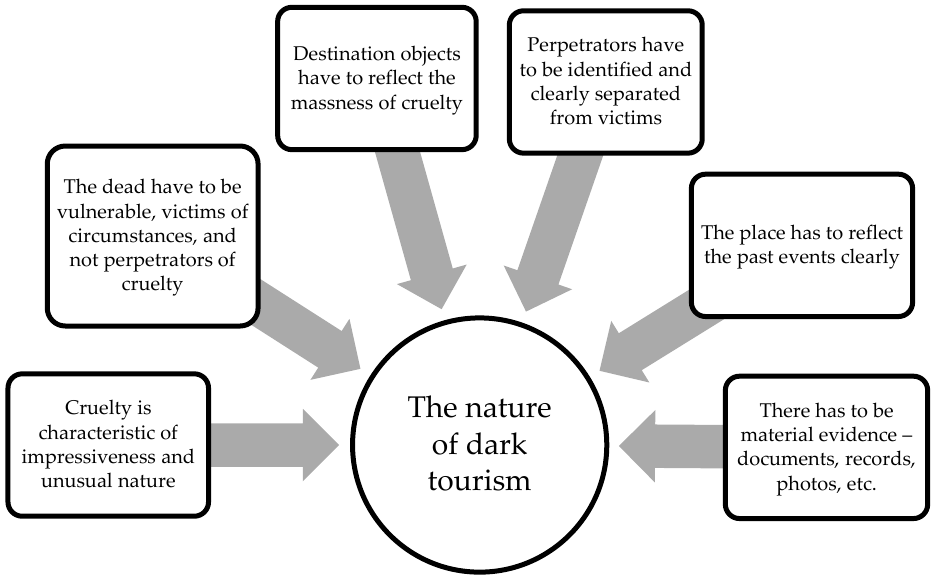
Figure 6. The nature of dark tourism. Source: Foley and Lennon (2000). Dark Tourism: The Attraction of Death and Disaster. London: Continuum.